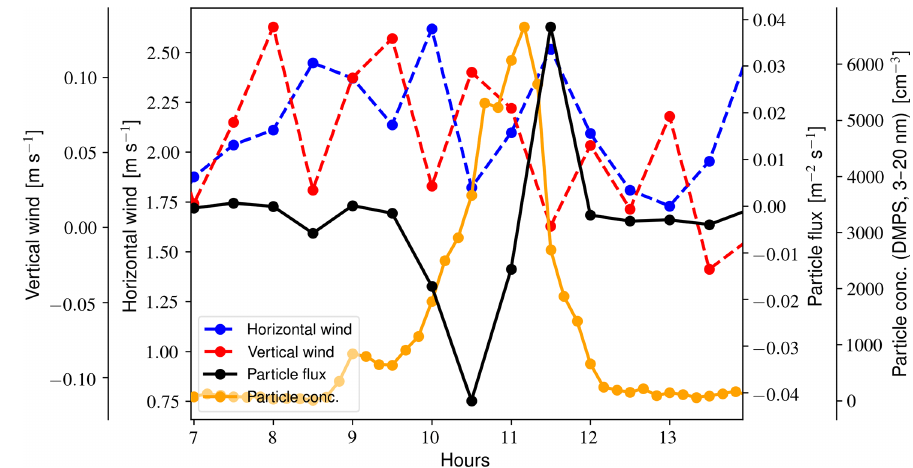
Figure 6. Time series of the vertical wind (33.6ma . g . l . ), horizontal wind (33.6ma . g . l . ), vertical flux of particles greater than 10nm (23ma . g . l . ) and number concentration of 3–20nm particles inside the canopy (8ma . g . l . ) on 21 August 2015.